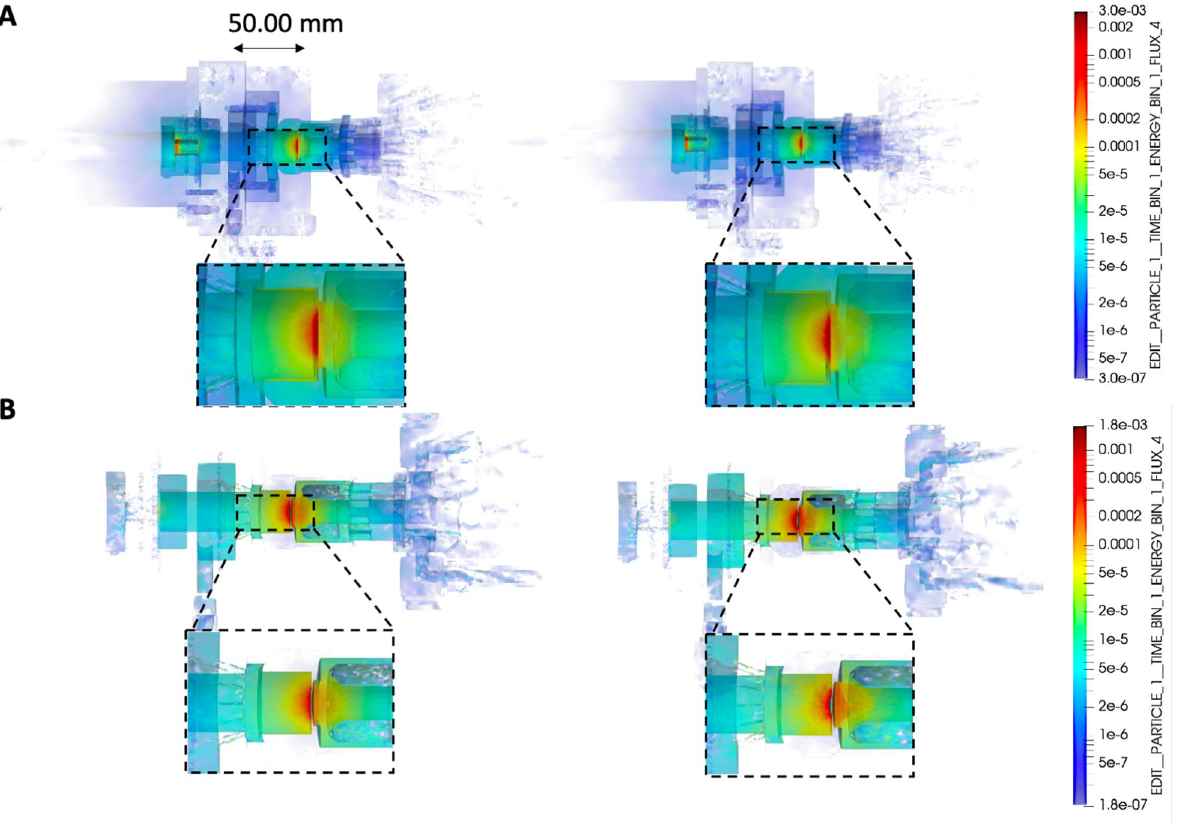
Figure 6. Panel ( A ), photon flux, arbitrary units. CEM03.03 model only taken as reference. Left, ideal target; Right, real target. Above, PTS relevant parts section; Below, zoom around the target region. Panel ( B ), neutron flux, arbitrary units. CEM03.03 model only taken as reference. Left, ideal target; Right, real target. Above, PTS relevant parts section; Below, zoom around the target region.